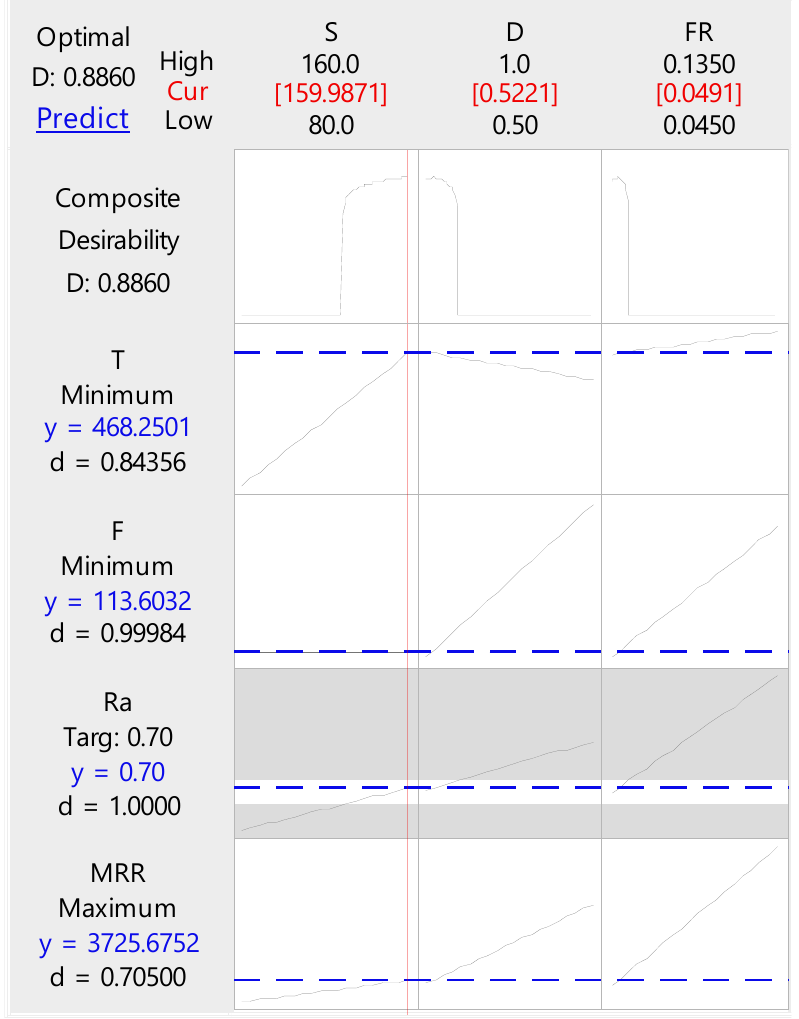
Figure 12. Optimization plot for responses using conventional cutting edge.